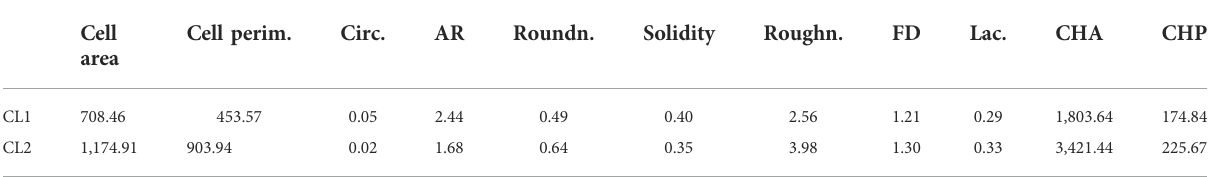
TABLE 3 Cluster centres for microglial shape